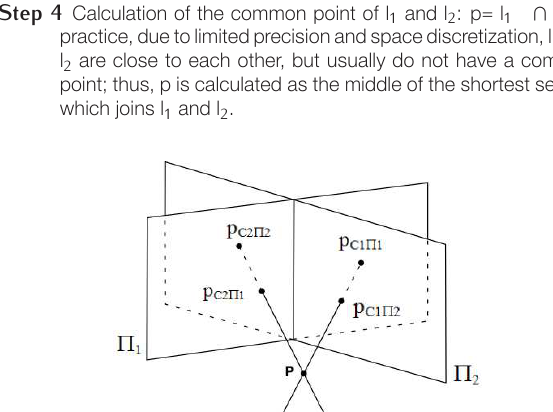
p C , from local 2D coordinate systems to the global 3D coor- 2Π2 dinate system.